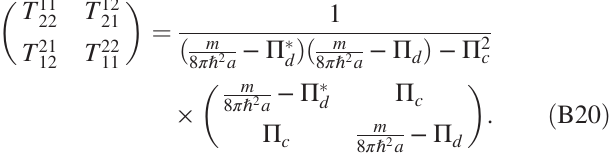
In the noncondensed phase, where v → 1 and u → 0 , the off-diagonal terms vanish and the diagonal elements reduce to the standard T matrix of a thermal gas.